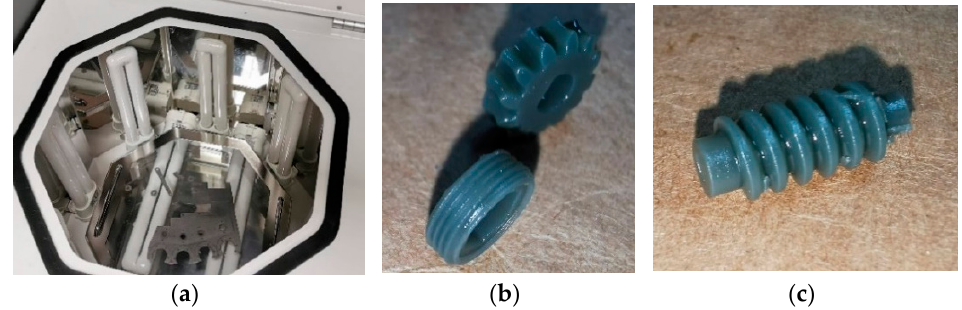
Figure 23. Printed green part curing and level of detail. ( a ) Curing ultraviolet oven, ( b ) gear and fillet level of detail (thread pitch of 0.5 mm), ( c ) worm gear level of detail (module of 0.6 mm).